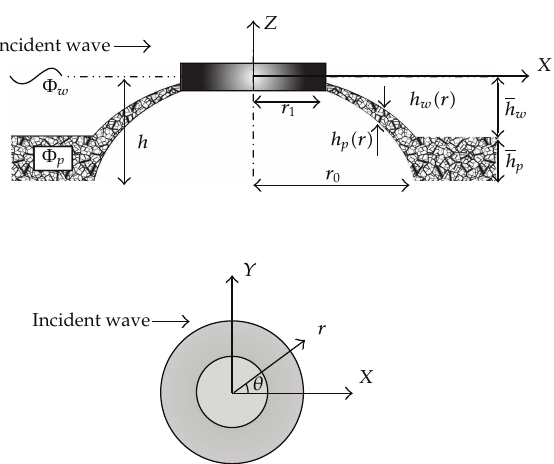
Figure 1: Definition sketch of a circular